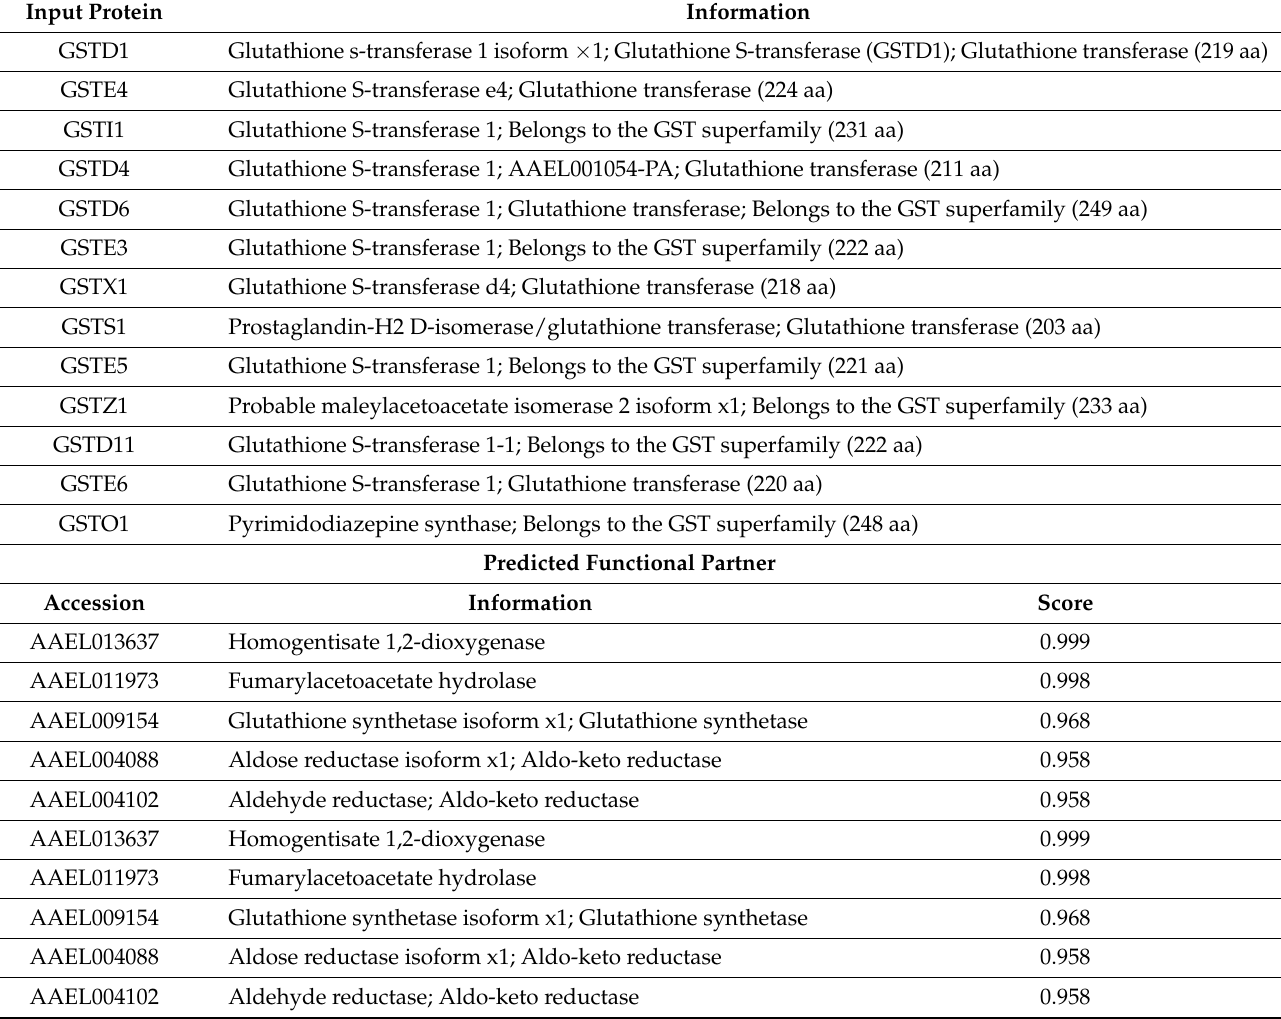
Table 2. Characteristics of input proteins and functional partners in GST-class protein-protein interactions from STRING 11.5